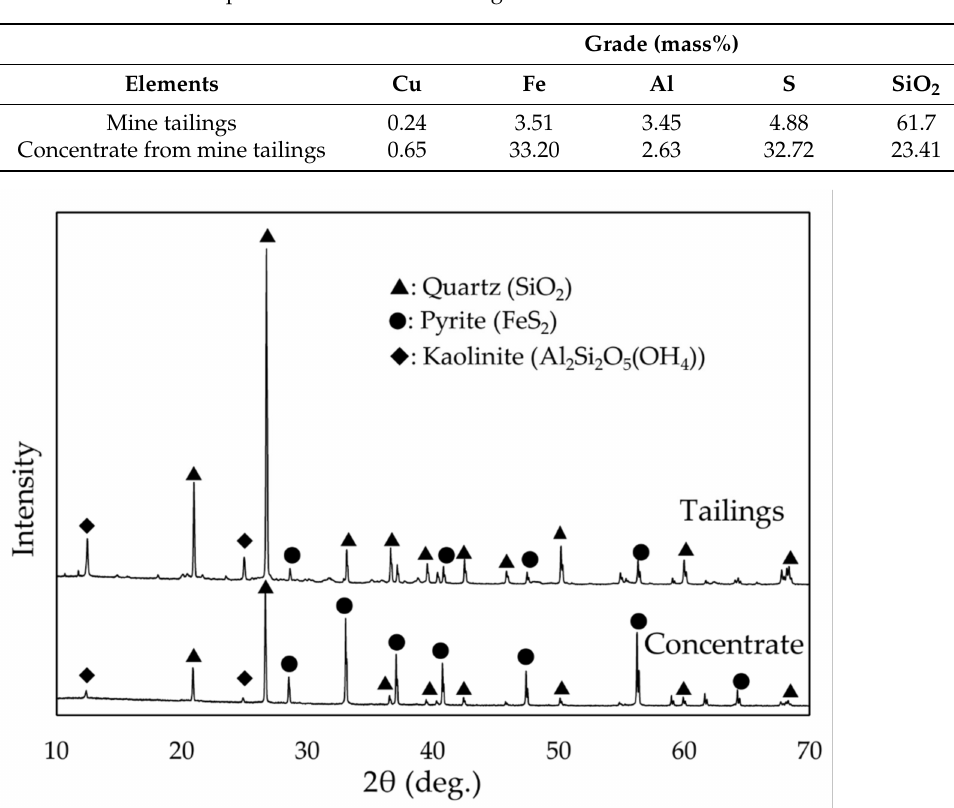
Table 1. Chemical compositions of the mine tailings and concentrate.